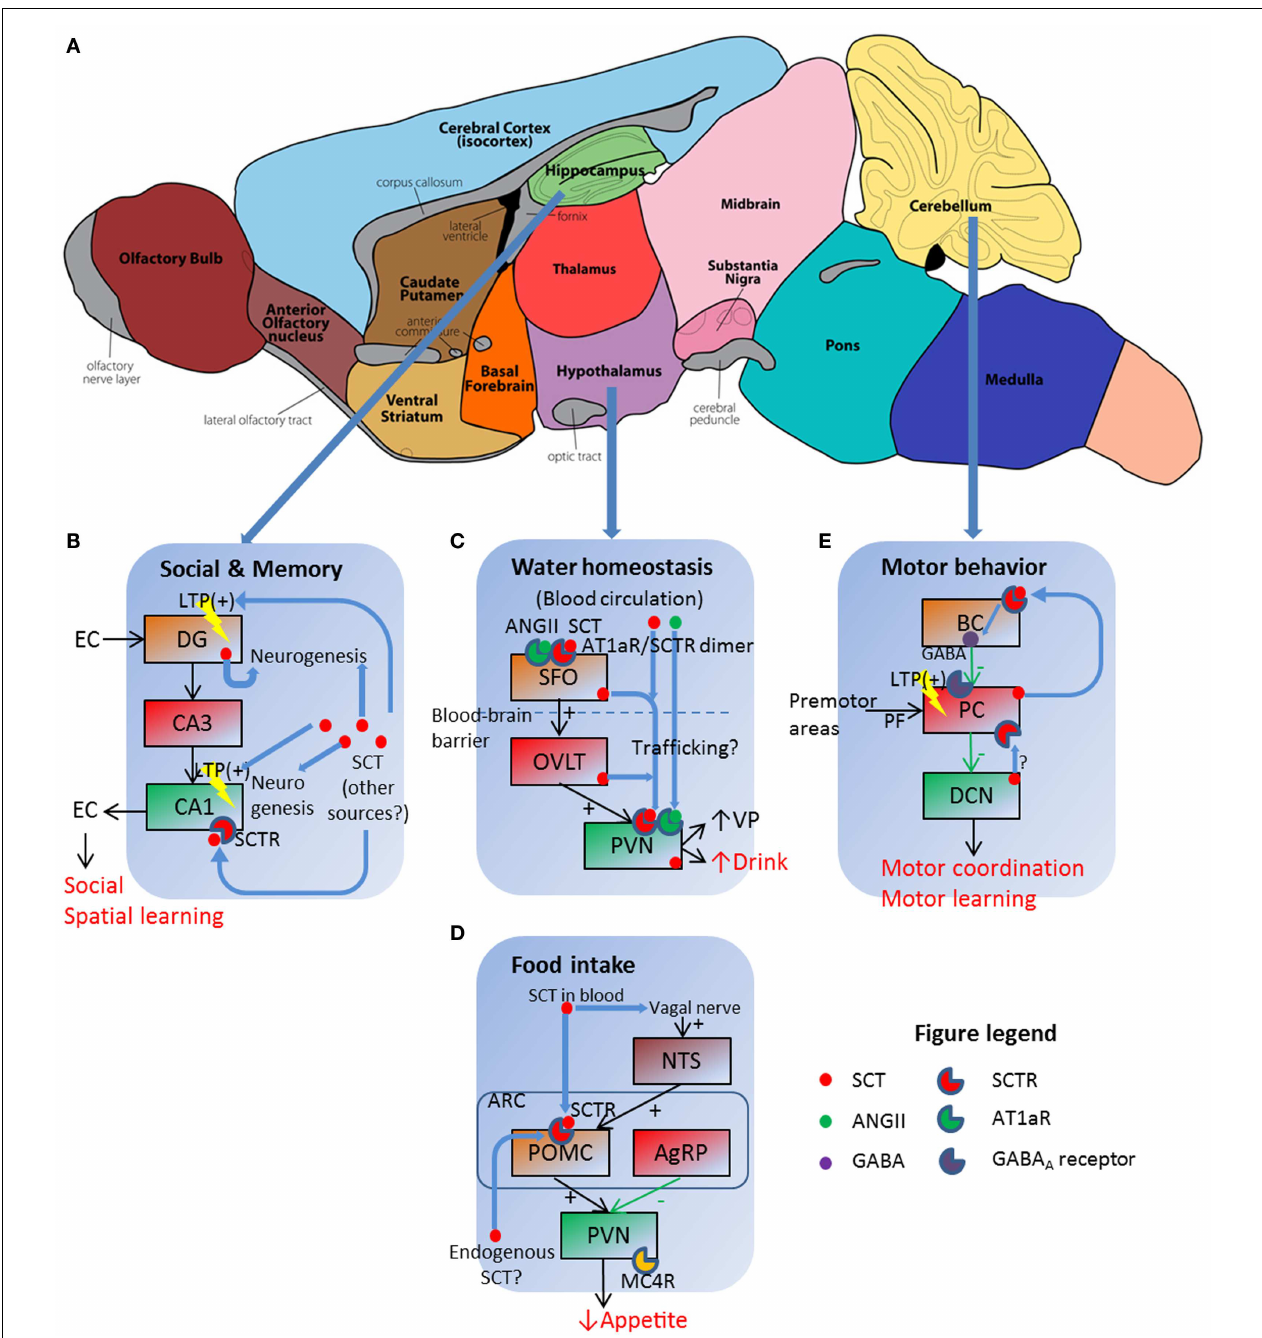
intake behavior. (D) Both vagal nerve and Arc neurons are responsive to SCT and further inhibit food intake via the activation of the melanocortin system. (E) SCT can induce presynaptic GABA release, and potentiate LTP in PF–PC synapse. BC, basket cell; PC, Purkinje cell; PF, parallel fiber. (A) is adapted from an illustration of the Gene Expression Nervous System Atlas (GENSAT) Project, NINDS Contracts N01NS02331 & HHSN271200723701C toThe Rockefeller University (NewYork, NY) with